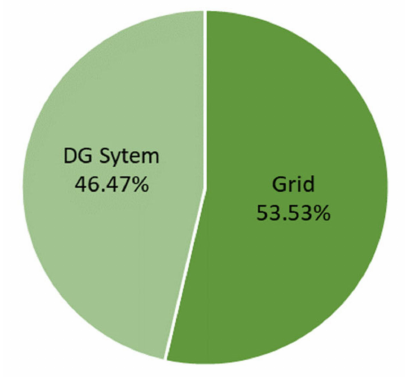
Figure 15. Grid support and DG energy